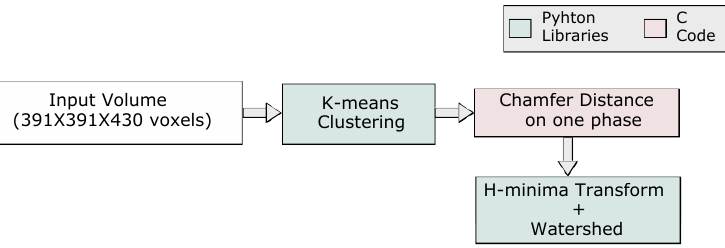
Figure 7. The protocol used for segmentation and watershed filtering.